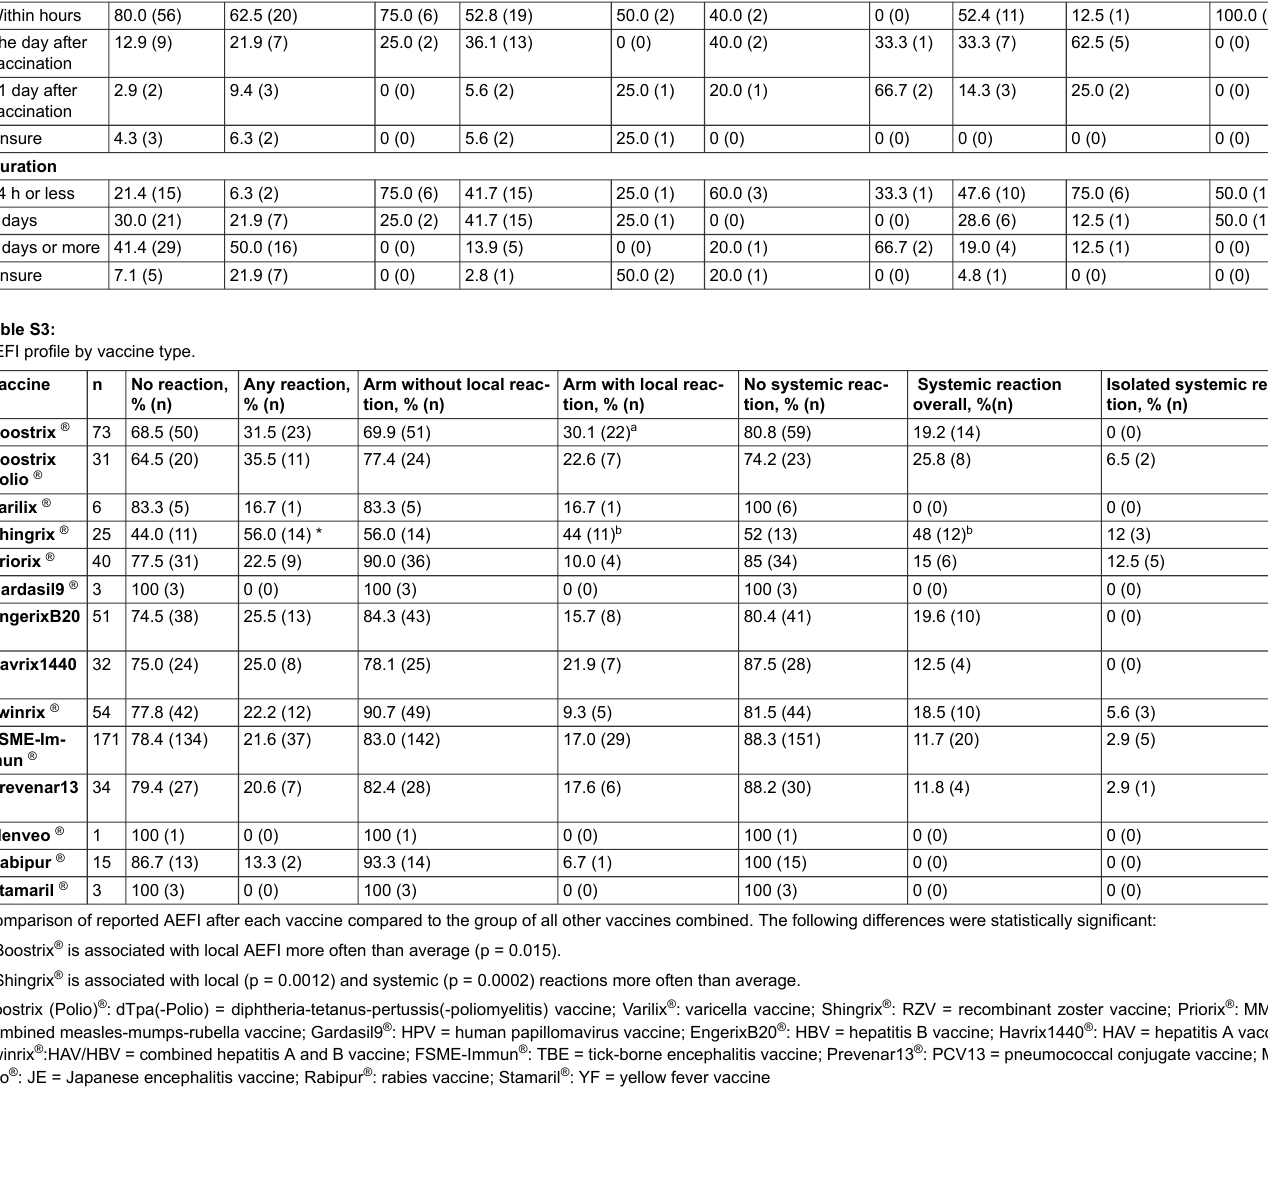
Local pain, % (n = 70)